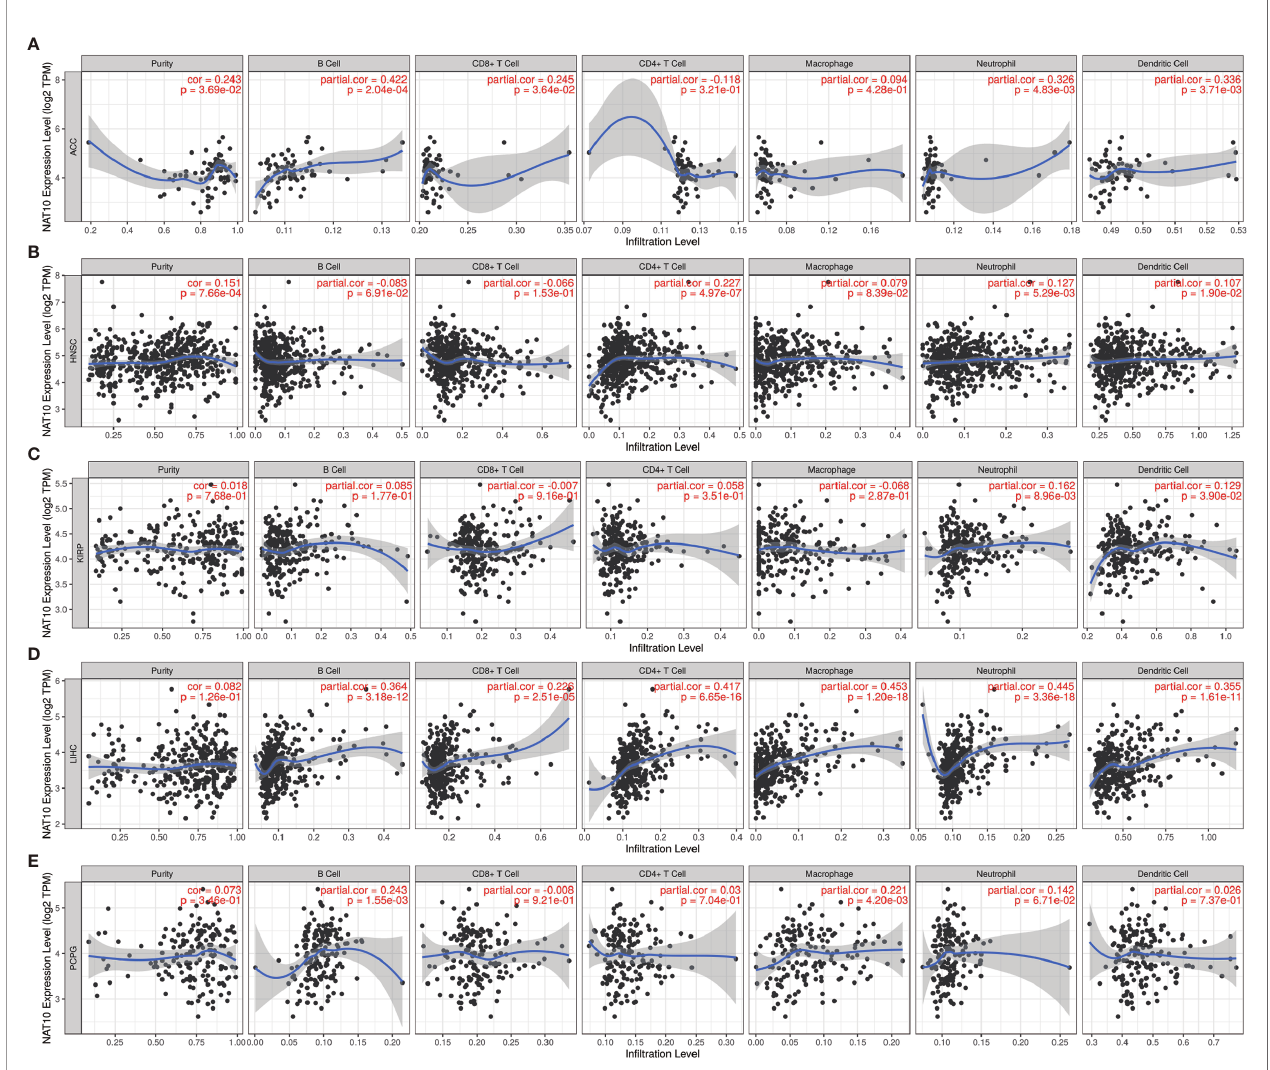
FIGURE 5 | Correlation of NAT10 expression with immune in fi ltration levels in ACC, HNSC, KIRP, LIHC, and PCPG. (A) Correlations of NAT10 expression with immune in fi ltration levels in ACC (A) , HNSC (B) , KIRP (C) , LIHC (D) , and PCPG (E)